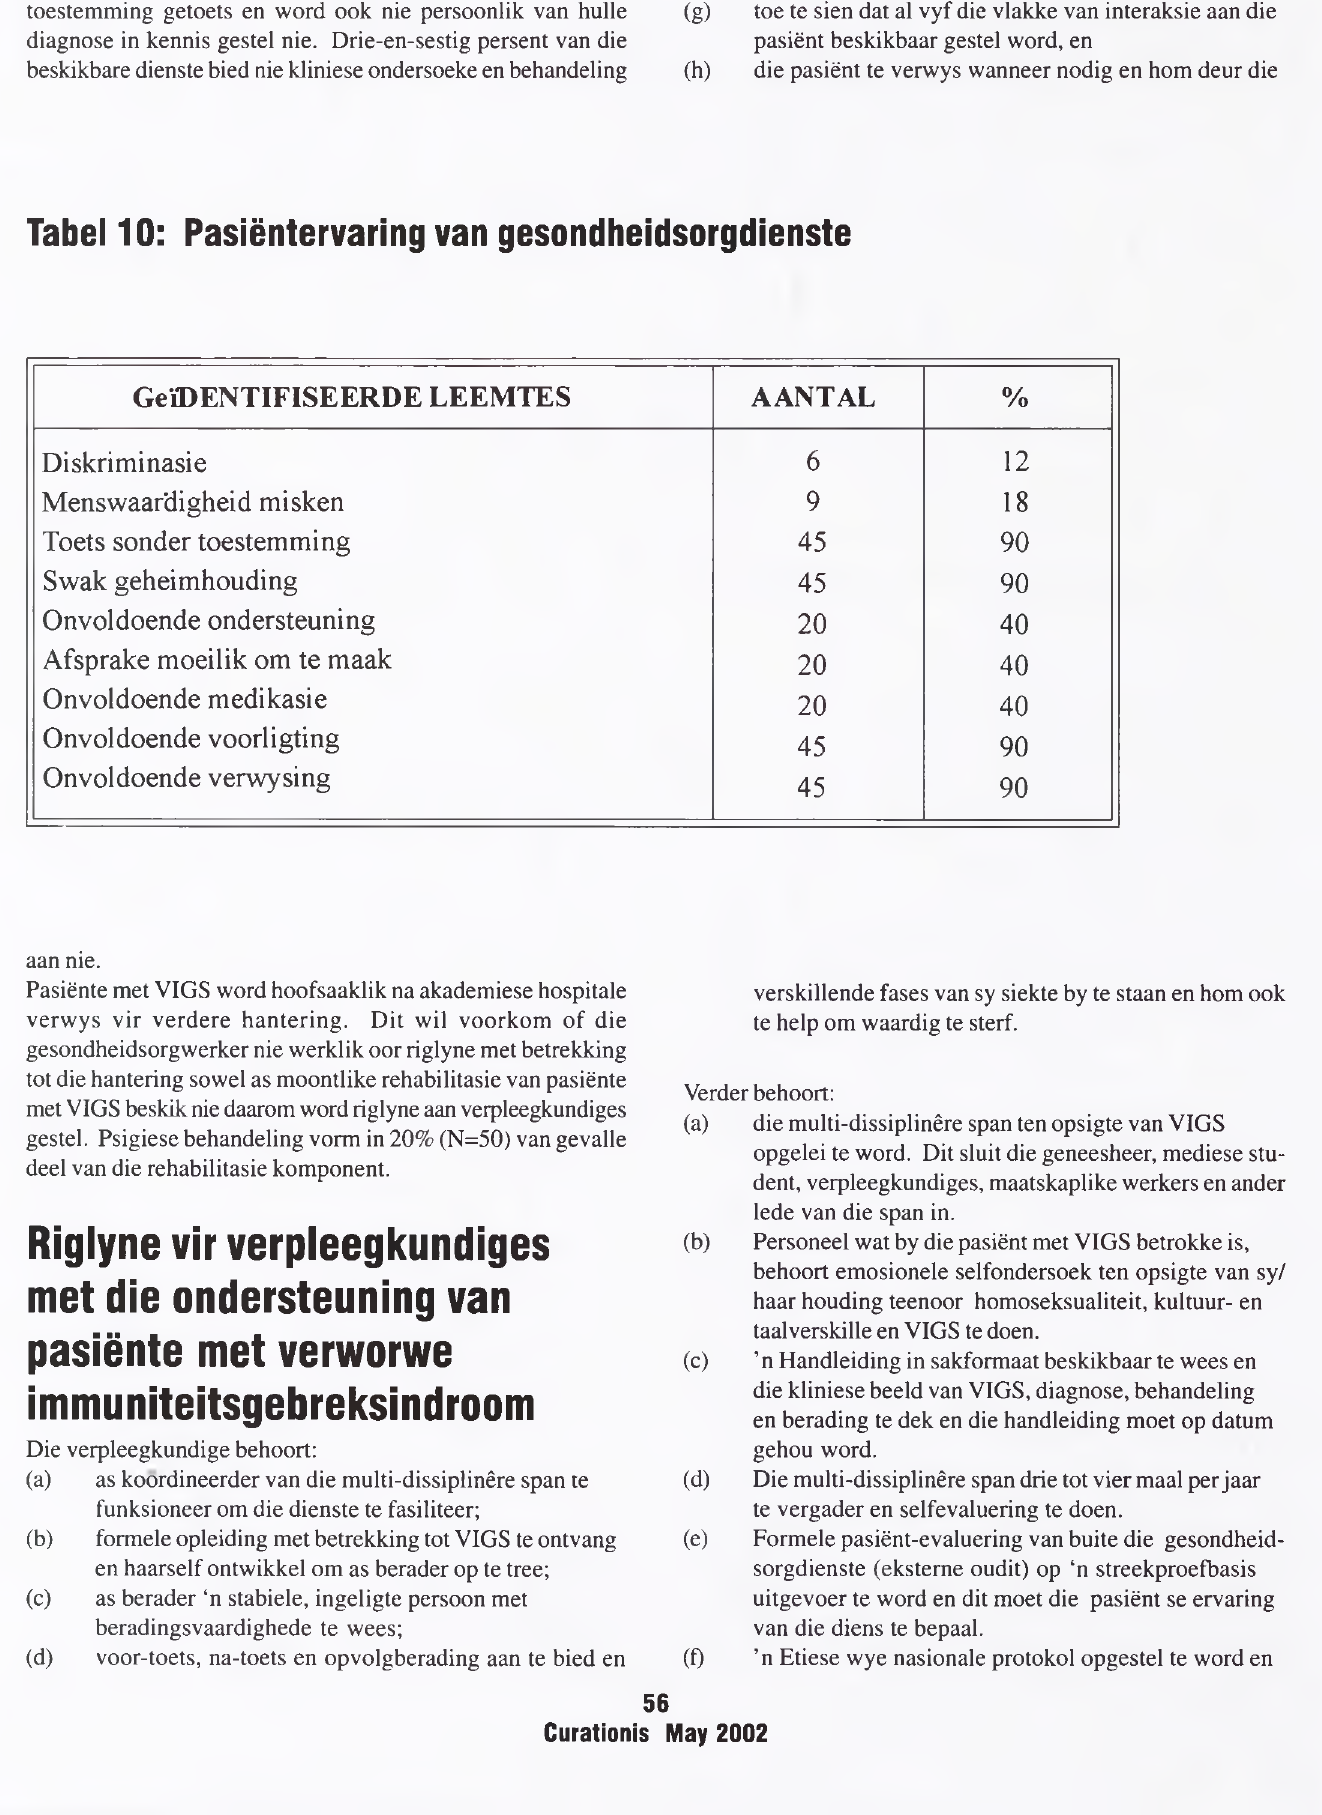
Tabel 10: Pasiëntervaring van